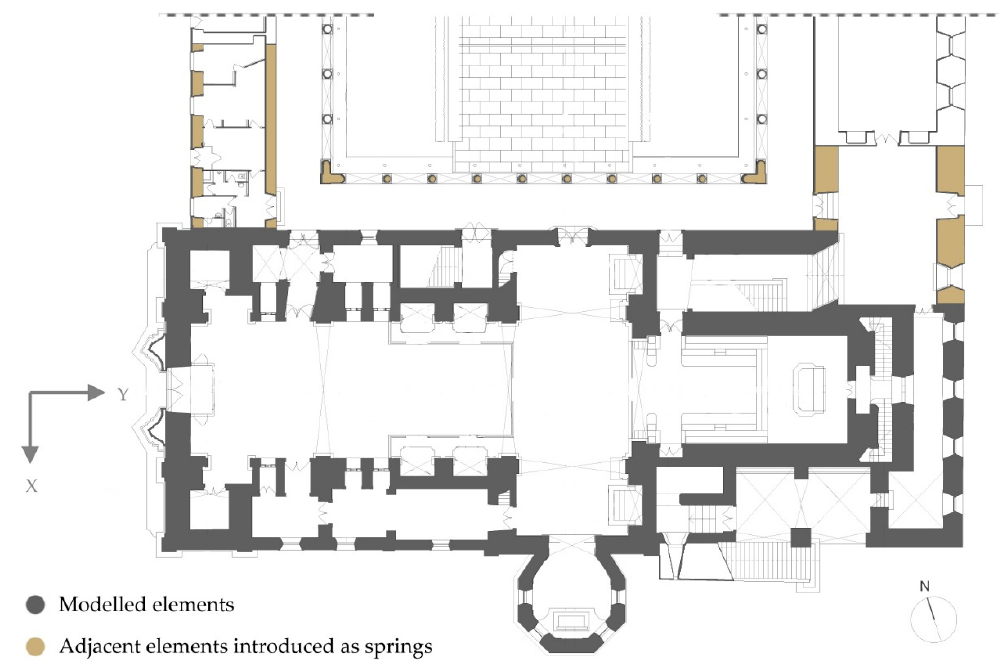
Figure 7. Plan view with the geometry considered for the numerical model.